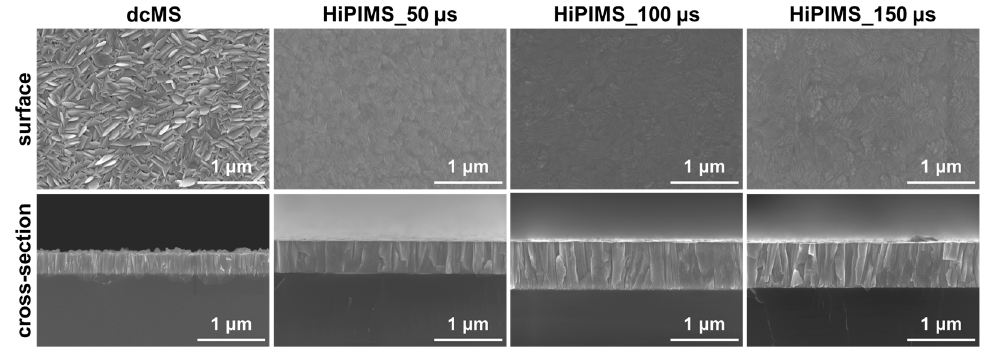
Figure 2. Surface and cross-section SEM images of W thin films with respect to HiPIMS pulse length.